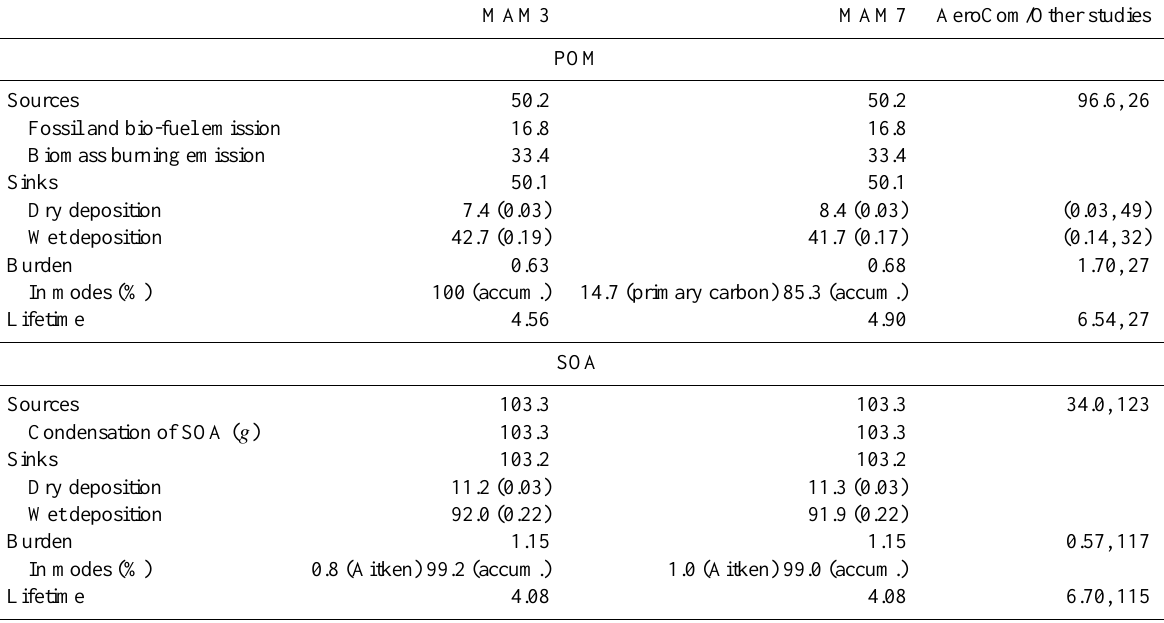
Table 5. Global budgets for POM and SOA. For POM, the means and normalized standard deviations (in %) from available models partic- ipating in AeroCom (Textor et al., 2006) are listed. The values in parentheses are mean removal rates (in day − 1 ), and normalized standard deviations (in %) as budget terms are not given in Textor et al. (2006). For comparison, removal rates (in day − 1 ) from MAM3 and MAM7 are listed in parentheses. For SOA, the mean and normalized standard deviations (in %) from other studies are from Farina et al. (2010) and references therein.